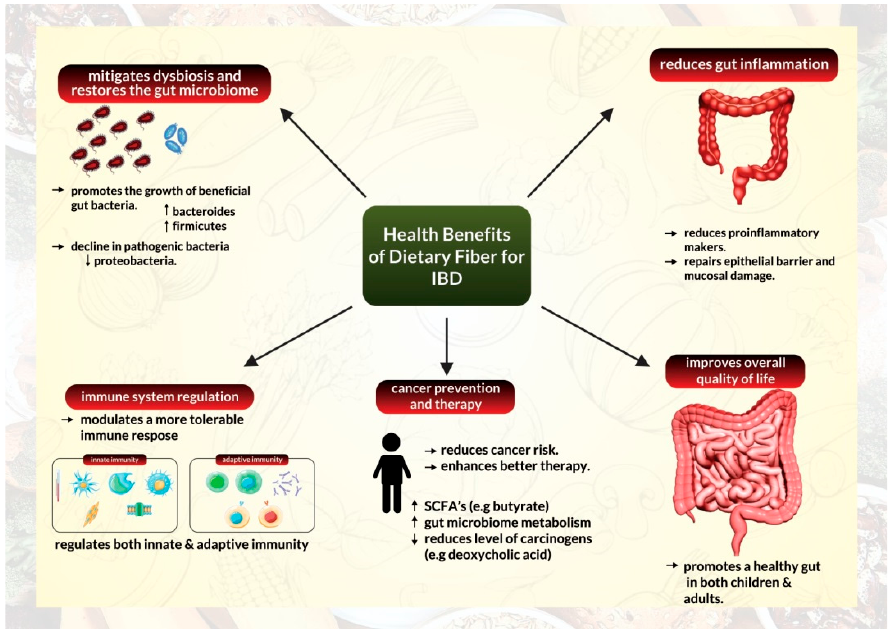
Figure 2. Health benefits of a high-fiber diet for management of inflammatory bowel disease.